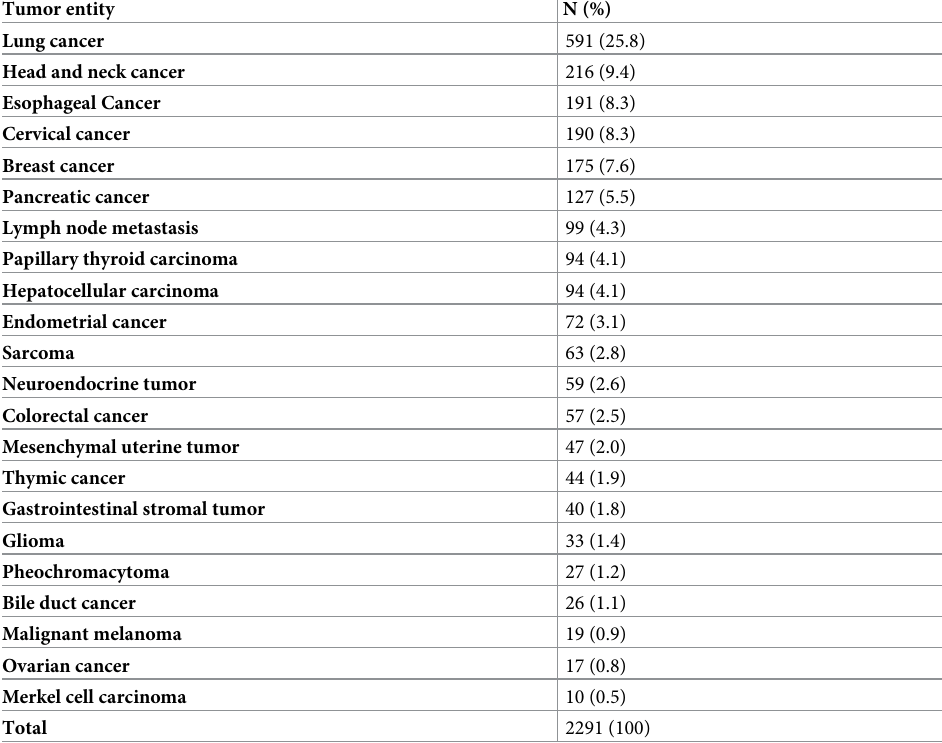
Table 1. Overview of the included tumor entities of the GLUT 1